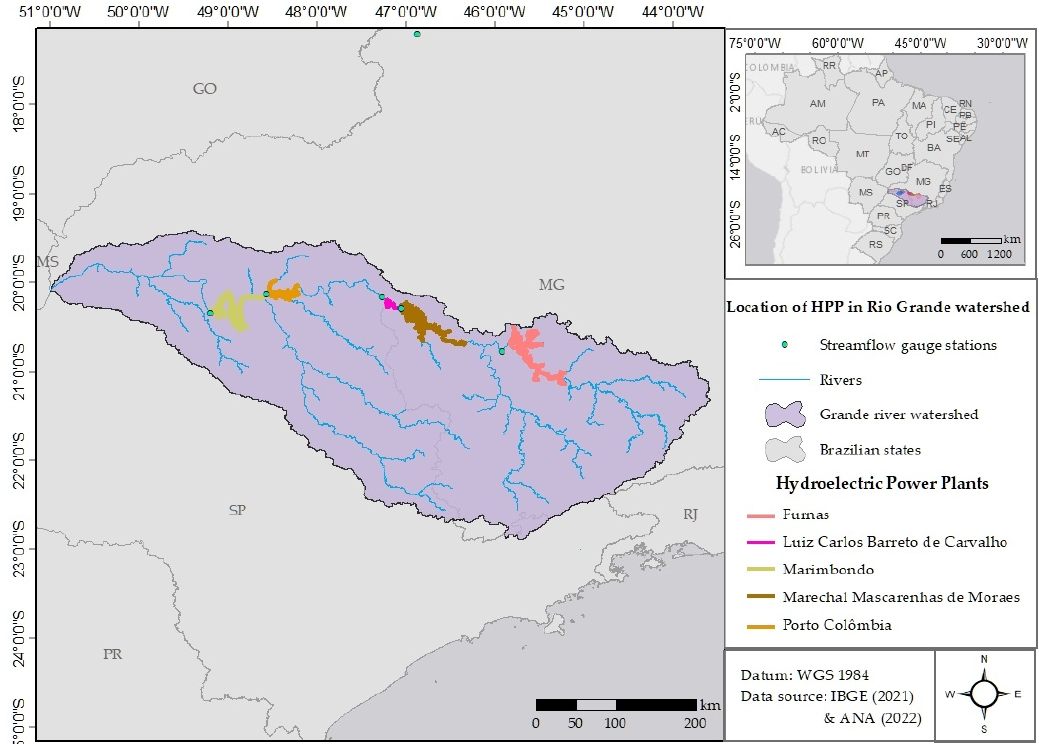
Figure 3. Location of hydroelectric plants on the Rio Grande, operated by the Furnas System.